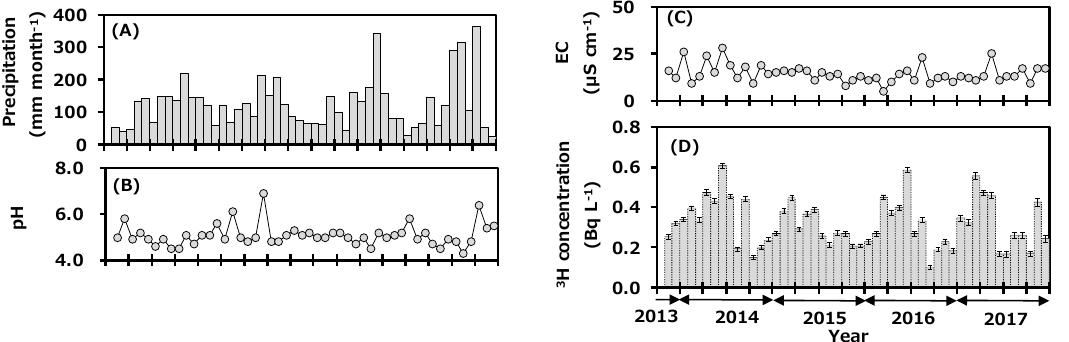
Figure 2. Monthly variations of precipitation amount ( A ), pH ( B ), electrical conductivity (EC) ( C ), and tritium concentration ( D ) in precipitation collected at Toki, Japan before (2013–2016) and after (2017) the first campaign of the deuterium plasma experiment.